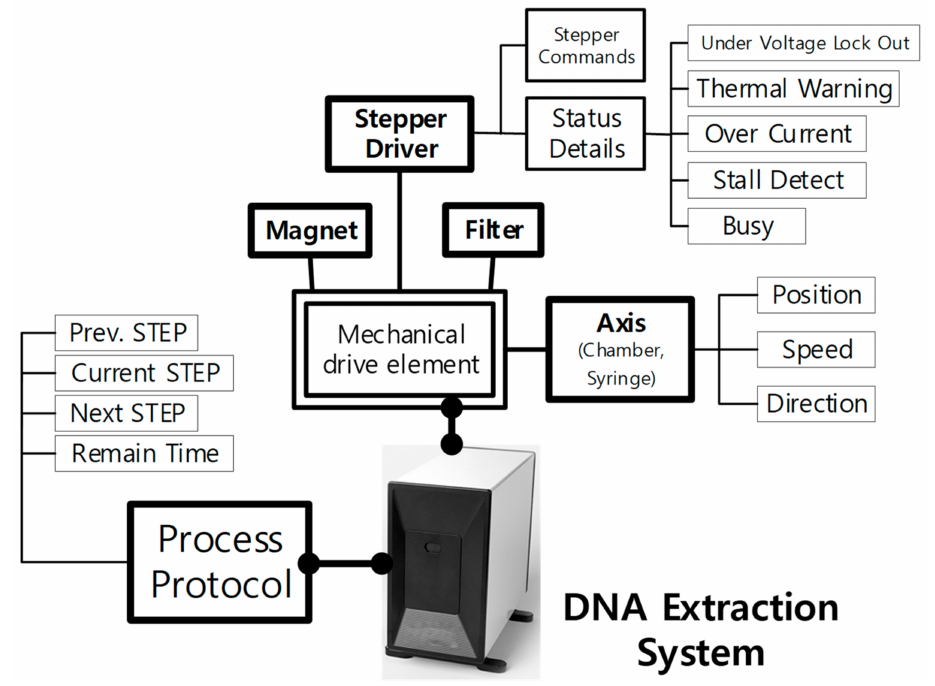
Figure 5. Information model of DNA extraction system.